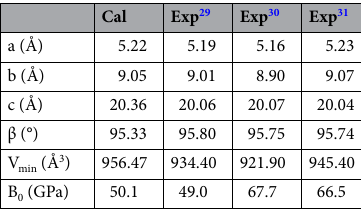
Table 1. Structural data of bulk